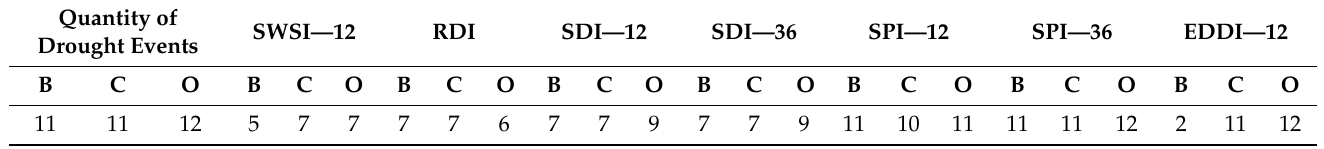
Table 14. Occurrence of drought events independent of their severity. The abbreviations (B, C, and O) represent Banabui ú , Castanh ã o, and Or ó s,